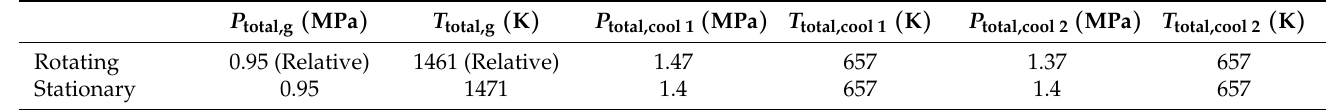
Table 1. Inlet boundary conditions of high-temperature gas and coolant under rotating and station- ary conditions.